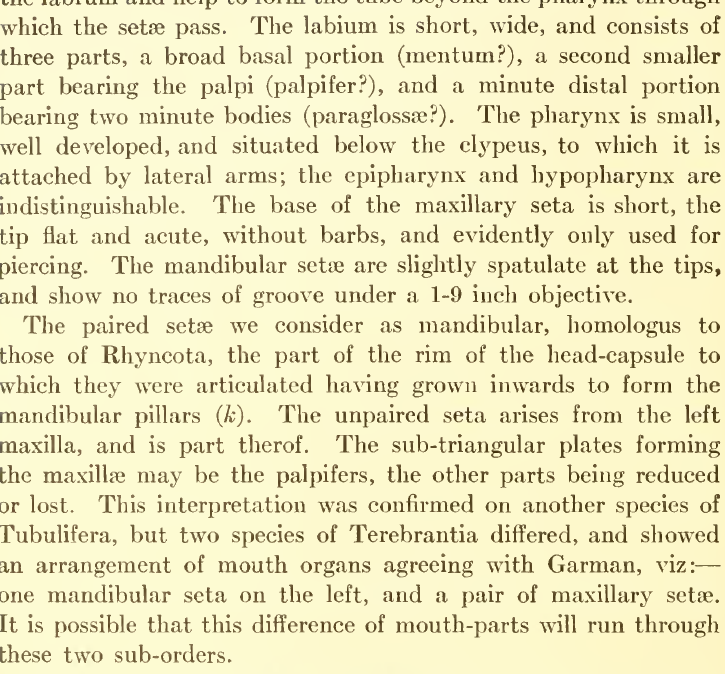
Uzel's figure of JEolothrips Jasciata does not bear out his sug- gestion that the unpaired seta is a development of the epipharynx, and in the species herein figured, there is no doubt of its maxillary